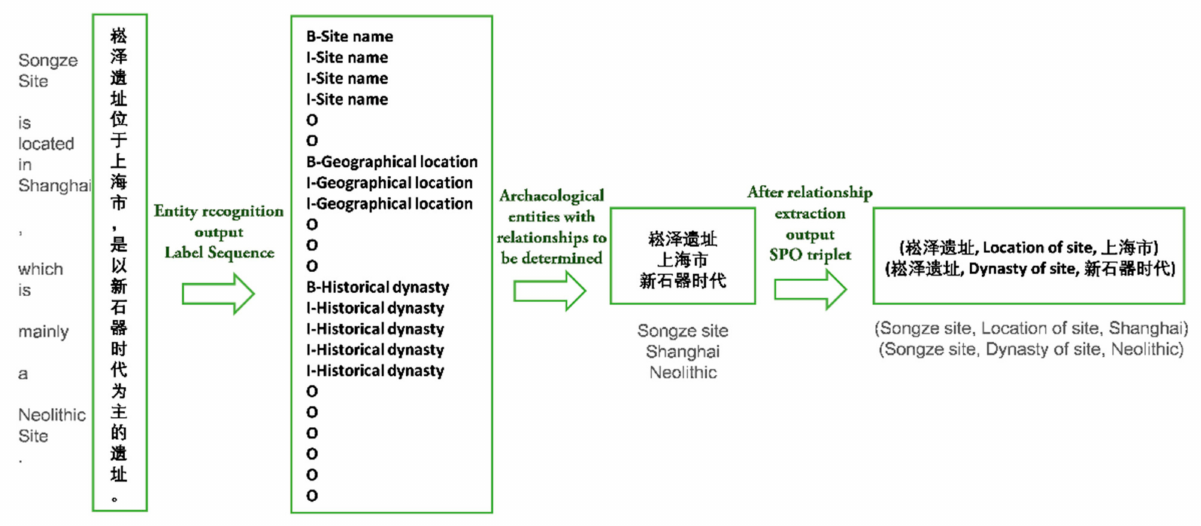
Figure 1. Demonstration of information extraction on archaeological site